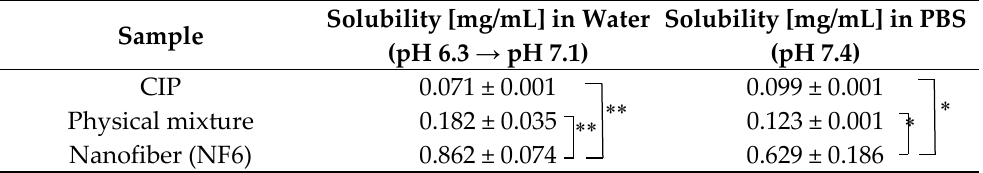
Table 5. Solubility data of the samples in distilled water and phosphate buffer. The dissolution of the ciprofloxacin (CIP) shifted the pH from 6.3 to 7.1 in distilled water. The nanofiber NF6 has significantly higher (** p < 0.01; * p < 0.05) solubility than the physical mixture and the raw CIP powder. Statistical analysis: Two-sample t -test.